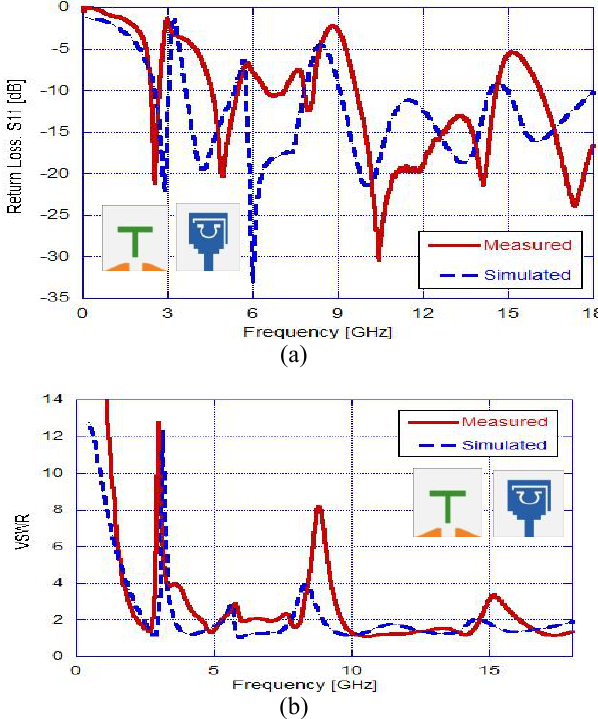
Figure 10: Measured and simulated (a) return loss, S 11 and (b) VSWR for the proposed triple band notched antenna.